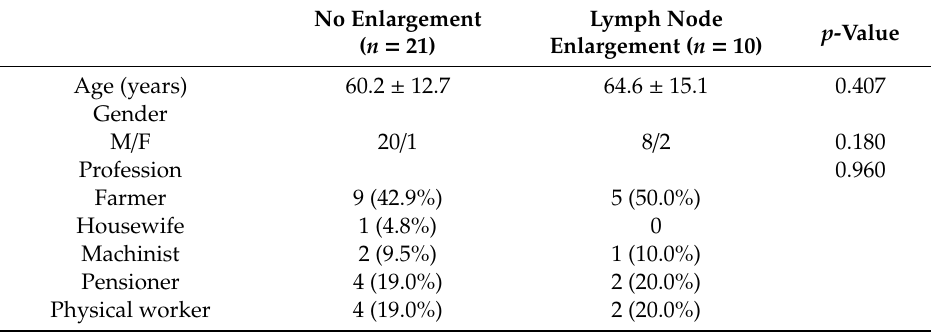
Table 3. The potential risk factors for lymph node